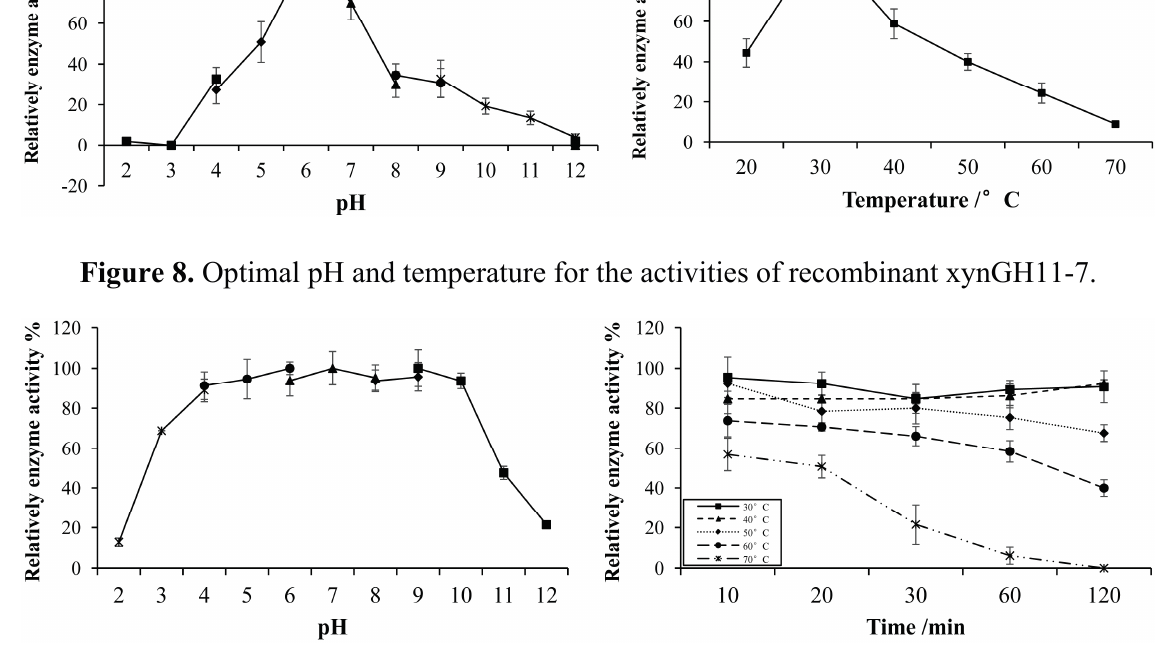
Figure 9. Stability of recombinant xynGH11-7 at different pH and